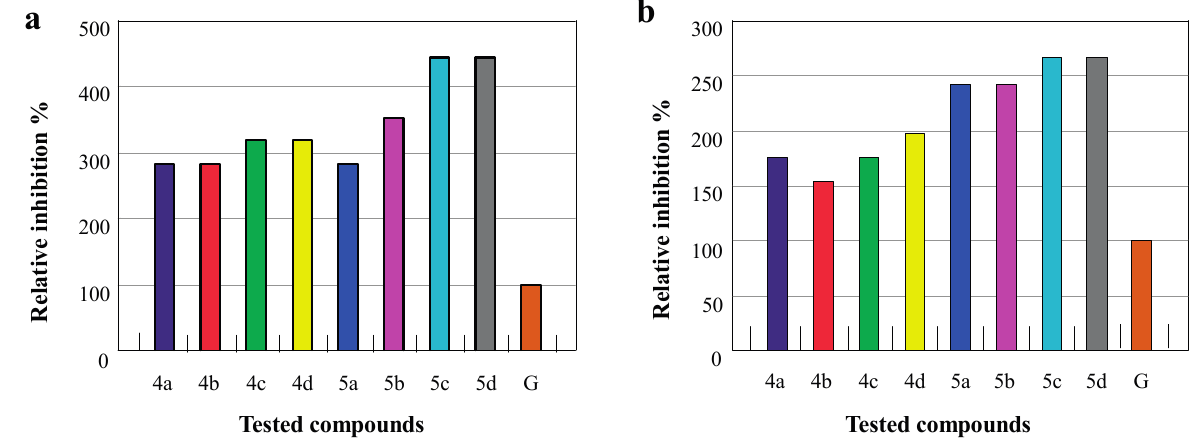
Figure 4. ( a ) The relative inhibition activity of compounds 4a – d and 5a – d against Aspergillus niger ; ( b ) The relative inhibition activity of compounds 4a – d and 5a – d against Penicillium citrinum . G: